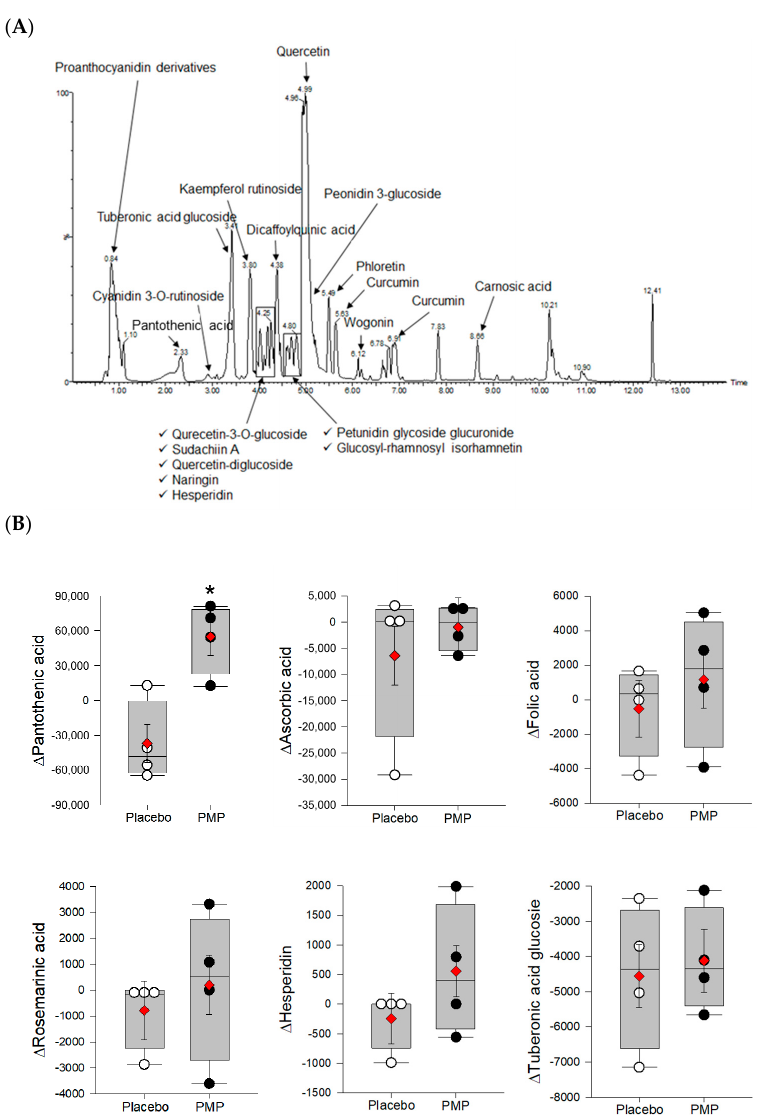
Figure 5. ( A ) The UPLC-Q-TOF-MS chromatographic fingerprint of the PMP study product; and ( B ) change in plasma after eight-week supplementation. The y-axis of box plots indicates the change in the relative peak area of each vitamin and phytonutrient. Statistical significances were determined by linear mixed-effects model (* P < 0.05). LSmeans ( ◆ ).